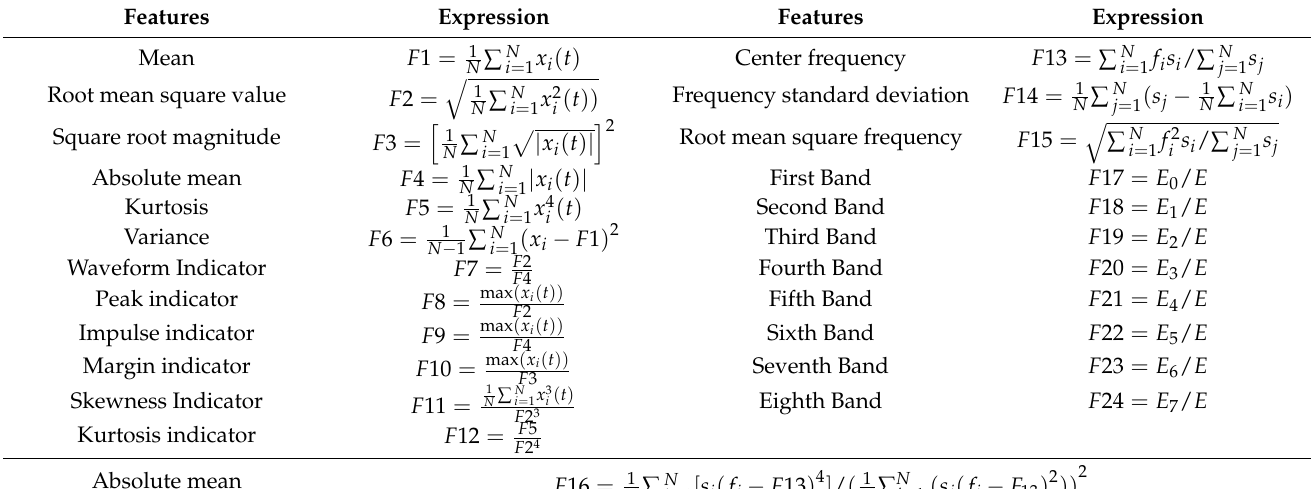
Table 1. Time and frequency domain and time–frequency domain characteristic